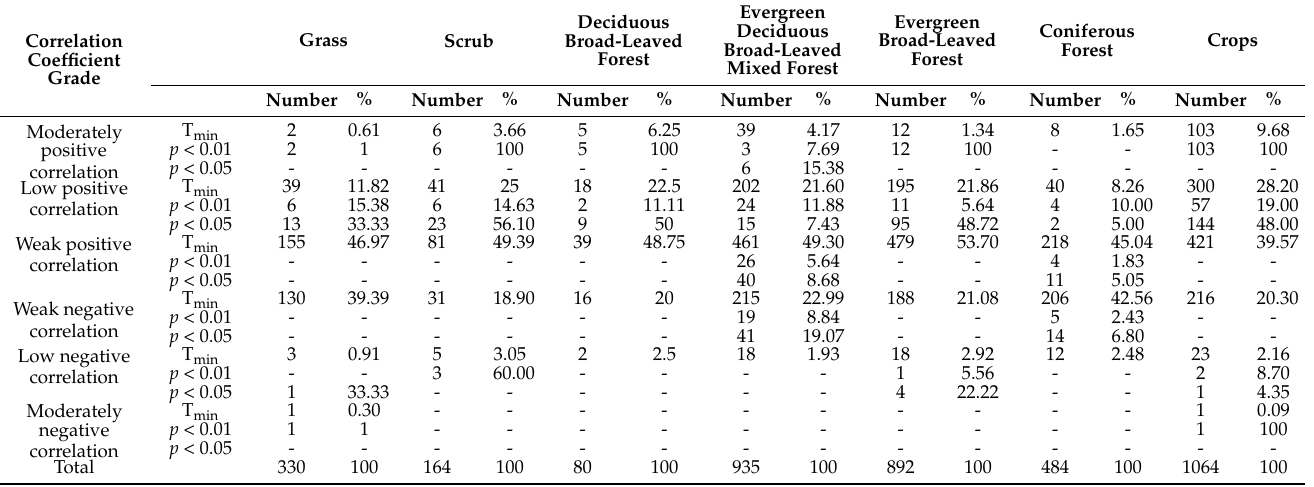
Figure 7. Correlations ( a ) and t -test analysis ( b ) between NDVI and nighttime minimum temperatures (T min ) of different vegetation types from 1982 to 2015. Table 3. Numbers and t -tests of grids occupied by different vegetation types and different T min correlation coefficients in Qinba Mountains.